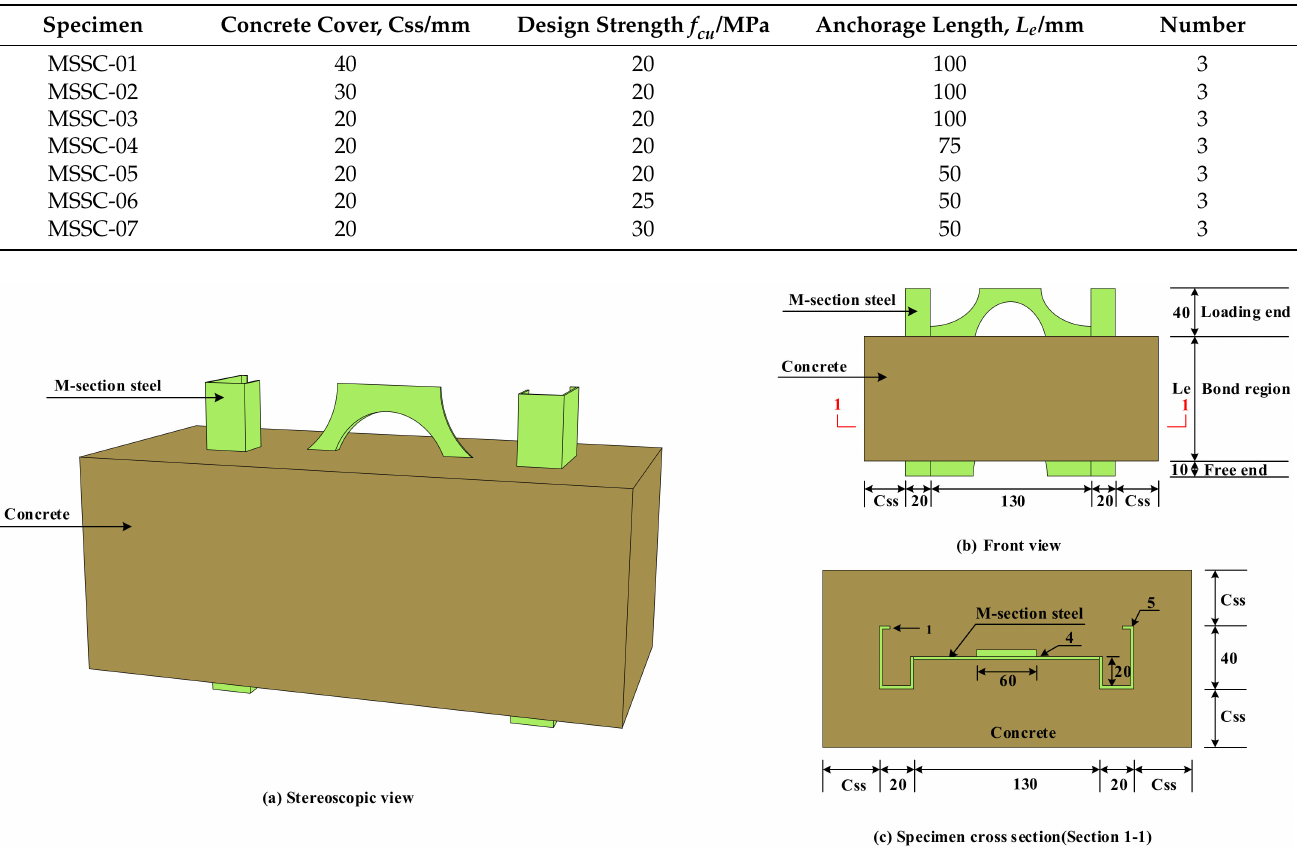
Figure 2. Schematic of MSSC specimens (unit: mm).